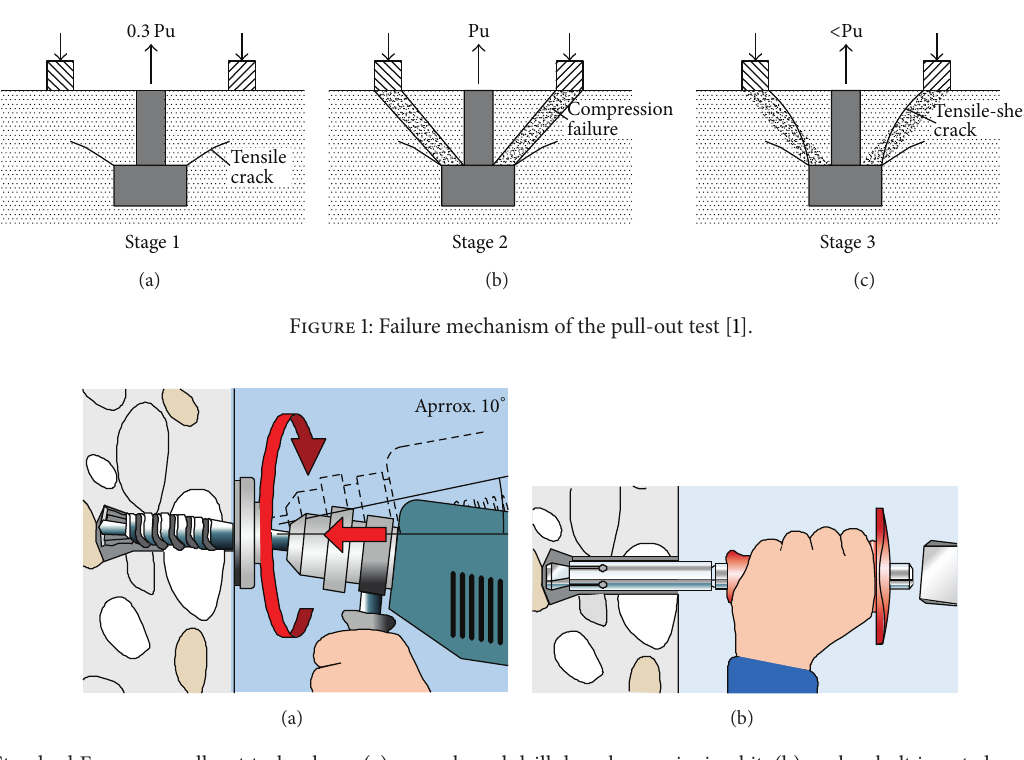
Figure 2: Standard European pull-out technology; (a) cone-shaped drill done by a swinging bit; (b) anchor bolt inserted and activated by manual hammering.